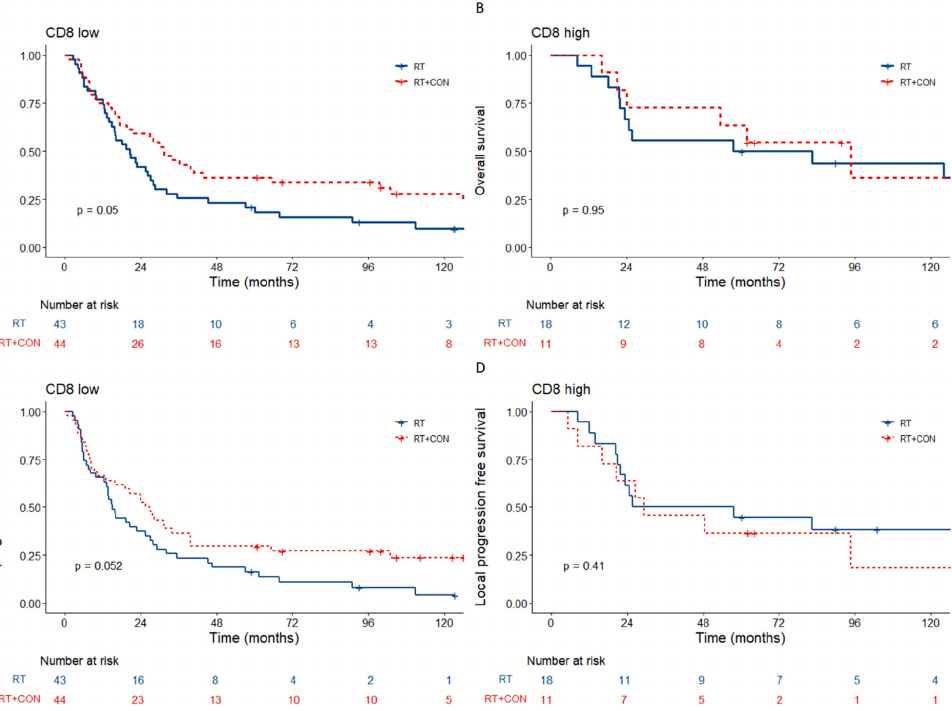
Figure 3. Kaplan–Meier plots for CD8 low and high according to treatment arm of BCON. p values are log-rank tests calculated as previously described. Overall survival for ( A ) CD8 low and ( B ) CD8 high according to RT only vs. RT+CON treatment arms. Local progression free survival for ( C ) CD8 low and ( D ) CD8 high according to RT only vs. RT+CON treatment arms.